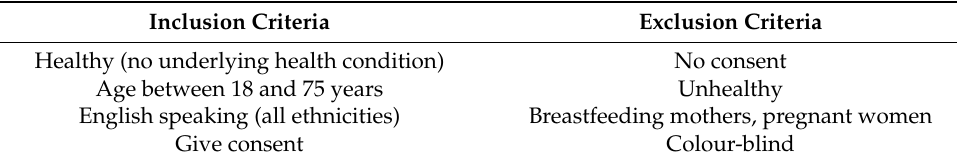
Table 1. Selection